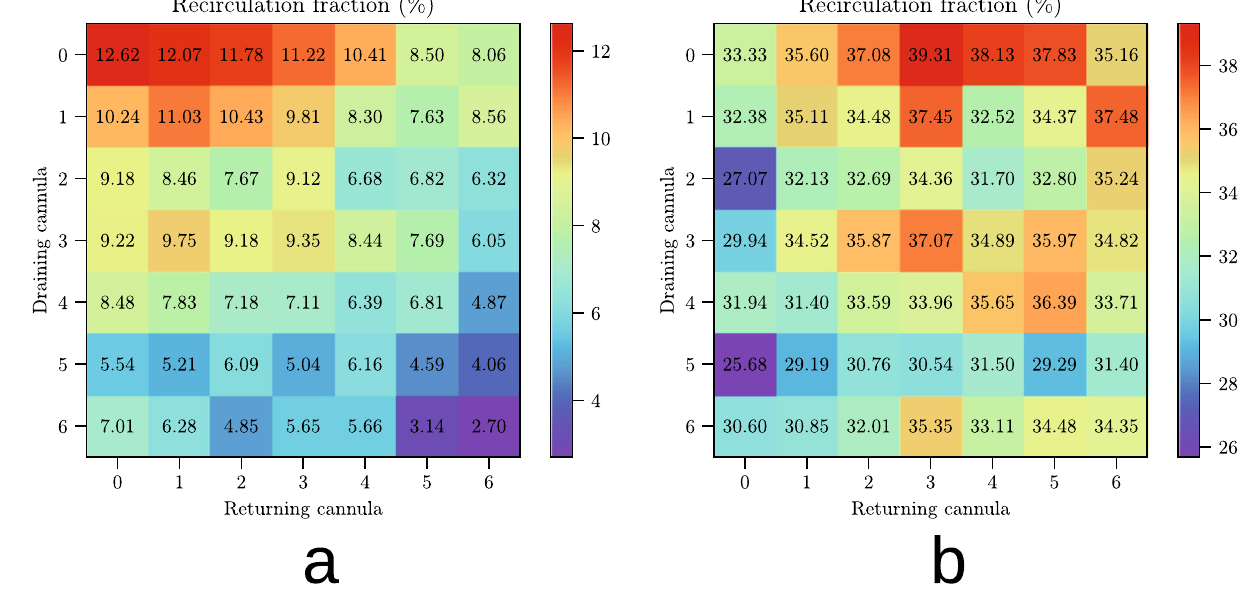
Figure 4. Recirculation charts for the two different ECMO flows. Oxygen recirculation for different cannula positions and the two considered ECMO flows. ( a ) 3 L/min. Mean: 7.66, standard deviation: 2.29. ( b ) 5 L / min . Mean: 33.57, standard deviation: 2.82. In the 3 L/min case a clear pattern emerges: when the cannulae are closer to each other, more recirculation occurs. In the 5 L / min , on the other hand, the blood comes in so fast that its behaviour is unaffected by the small changes in the cannulae’s positions. Regardless, recirculation is much more intense in the 5 L / min